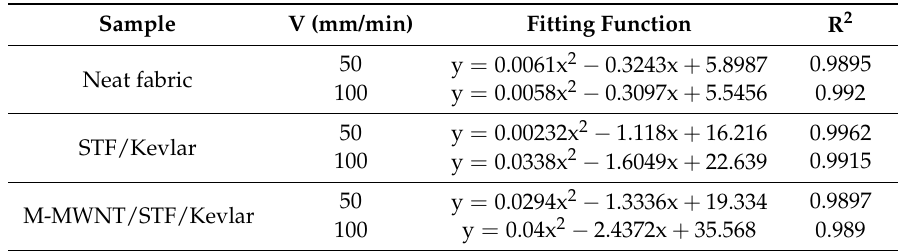
Figure 6. ( a ) Yarn pull-out force versus displacement curves of neat Kevlar. Pull the yarn at a constant speed at 5, 50, 100, 200 mm/min, ( b ) STF/Kevlar, ( c ) MWNT /STF/Kevlar ( d ) and curves of different fabric composite at the speed of 100 mm/min. Table 4. The fitting functions of pull-out